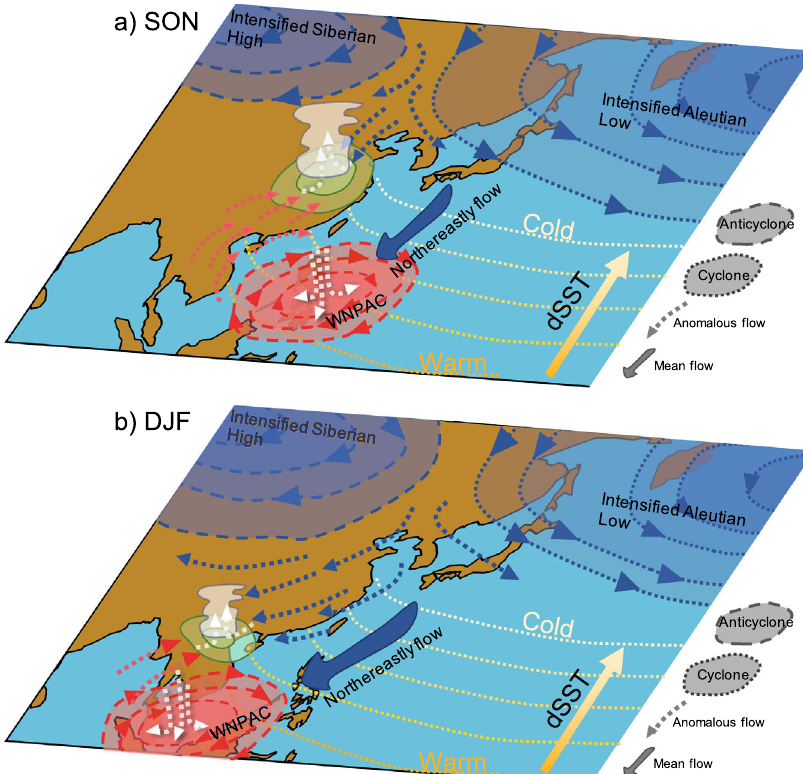
Fig. 4 Schematic plot for the mechanism of the autumn monsoon rainfall and WNPAC with its evolution in winter. a Autumn. b Winter. In a , the rainfall response is mainly forced by the slowdown of the AMOC. The AMOC-induced cooling in the atmosphere deepens the Siberian High and Aleutian Low that strengthens the northerly wind in North China in autumn. Meanwhile, the decline of AMOC also yields intensi fi ed meridional SST gradient that cools and desiccates the lower atmosphere along the coast of East Asia. The mean northeasterly wind transports the air of anomalous low MSE to the WNP that produces and sustains the WNPAC. The anomalous northerly wind associated with Siberian High and Aleutian Low converges with anomalous southerly wind associated with the WNAPC in South China, leading to notable precipitation. In b , the low-level mean northeasterly wind enhances in winter that shifts the WNPAC southward; the anomalous Siberian High and Aleutian Low also intensi fi es that makes the anomalous northerly wind prevail in South